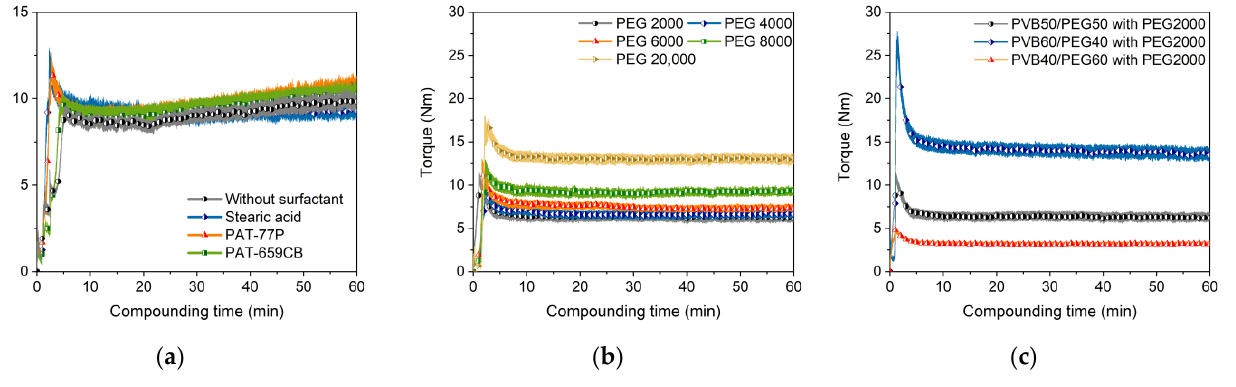
Figure 2. Compounding of PEG/PVB-based binder (110 °C, 60 vol%) with different compositions. ( a ) PEG 8000 as low molecular component and with or without different surfactants (5 wt%); ( b ) variation of the PEG M W with 5 wt% SA as surfactant; ( c ) variation of PEG/PVB ratio applying PEG 2000 as low molecular binder part and 5 wt% SA as surfactant.